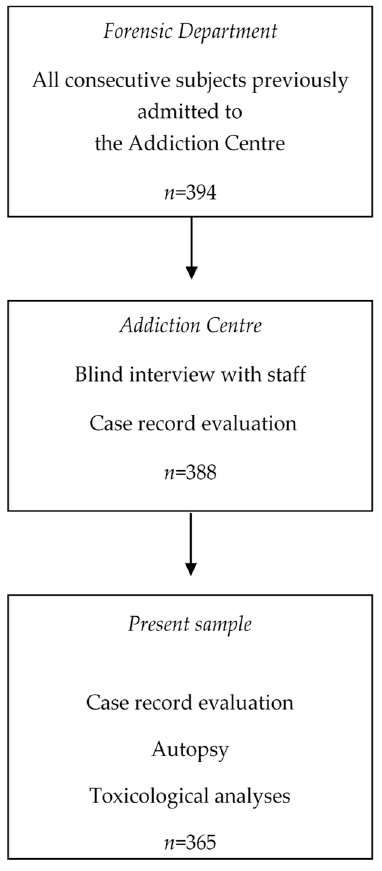
Figure 1. Flow diagram showing the sampling procedure.